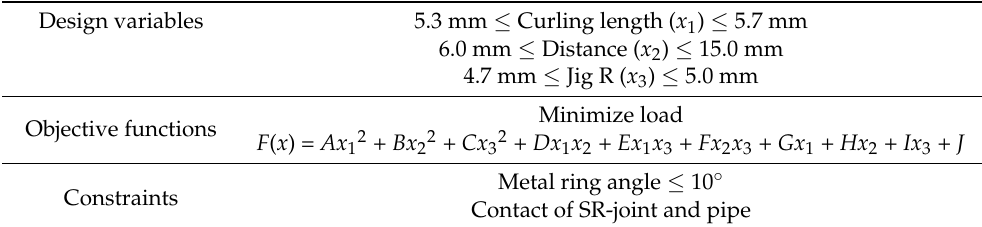
Table 2. Optimization problem set up.